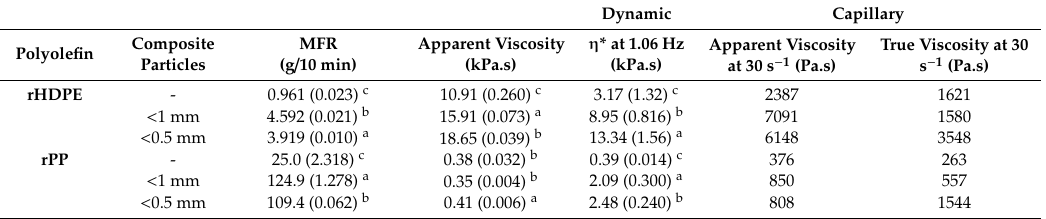
Table 4. Melt flow and Rheology results for polyolefins and rice hull composites.